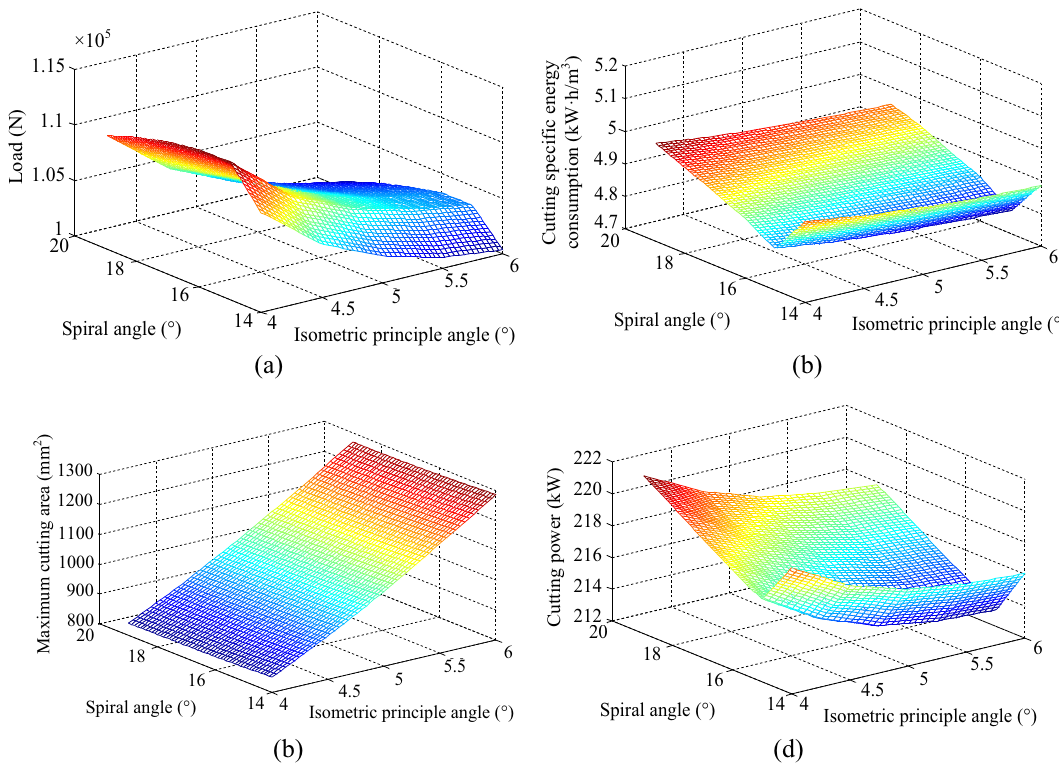
Figure 14. Relationship surfaces of each cutting performance index with the isometric principle angles and spiral angles: ( a ) cutting load; ( b ) cutting specific energy consumption; ( c ) maximum cutting area; ( d ) cutting